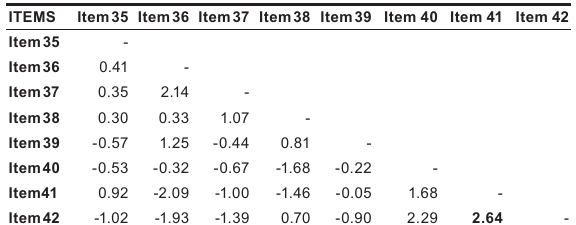
TABLE 10 Standardised residuals for Promotion dimension – Mall intercept study